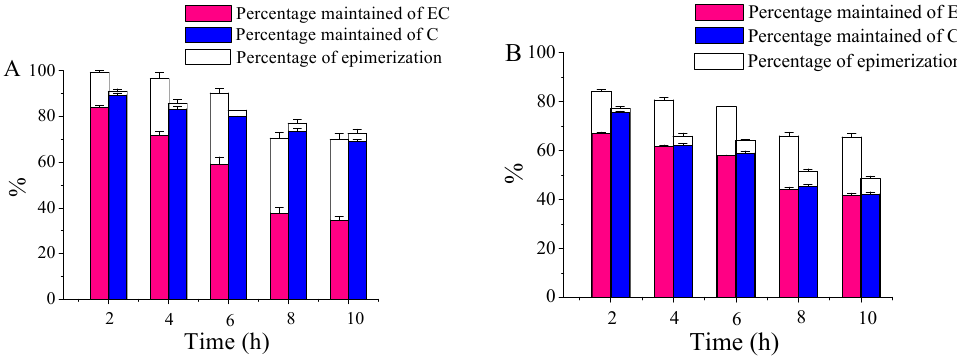
Figure 1. The changes in percentage of epimerization and the percentage maintained of EC and C with UVB radiation time: ( A ) water, 575 μ M; ( B ) ethanol, 575 μ M.